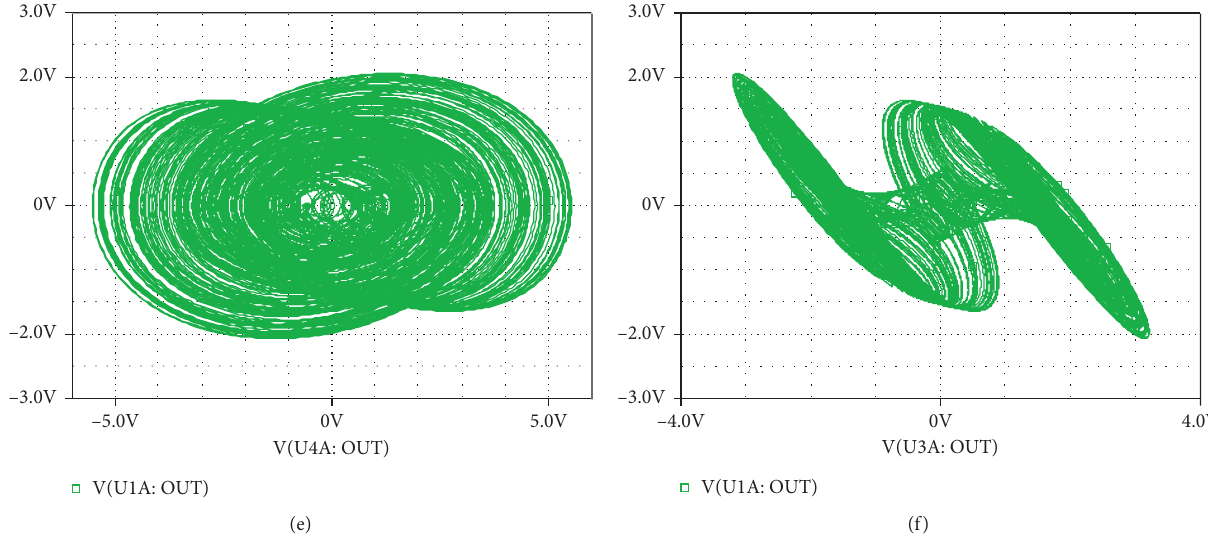
Figure 17: Two-dimensional views (left panel) of the symmetric double-scroll chaotic attractors computed for a � 5 . 0, μ � 1 . 0, and k � 0 . 00 and the corresponding PSpice simulation results (right panel) obtained for R c � 11 . 13 k Ω and R k � ∞ with the initial point ( 0 . 5 , 0 , 0 )